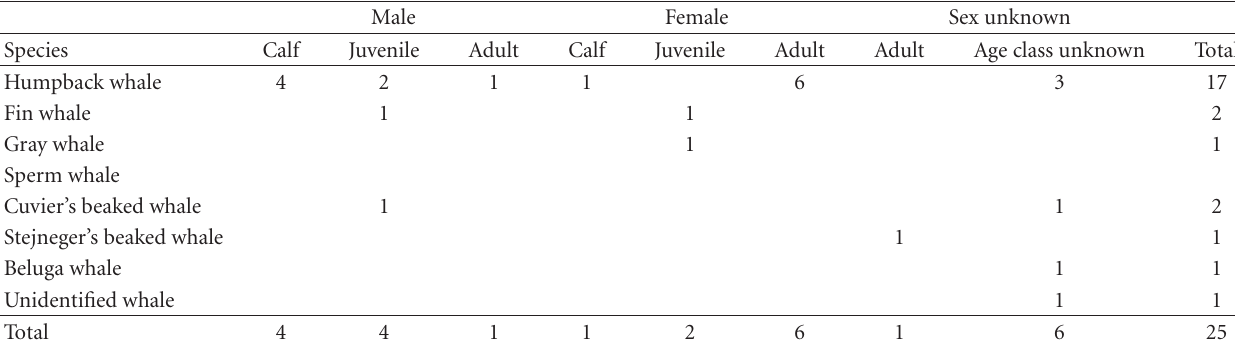
Table 3: Sex and age classes of the 25 whales known to have been killed by vessels.